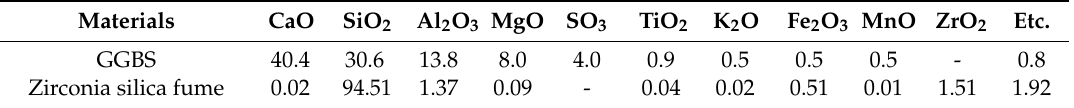
Table 1. Chemical compositions of ground granulated blast furnace slag (GGBS) and zirconia silica fume (ZSF).